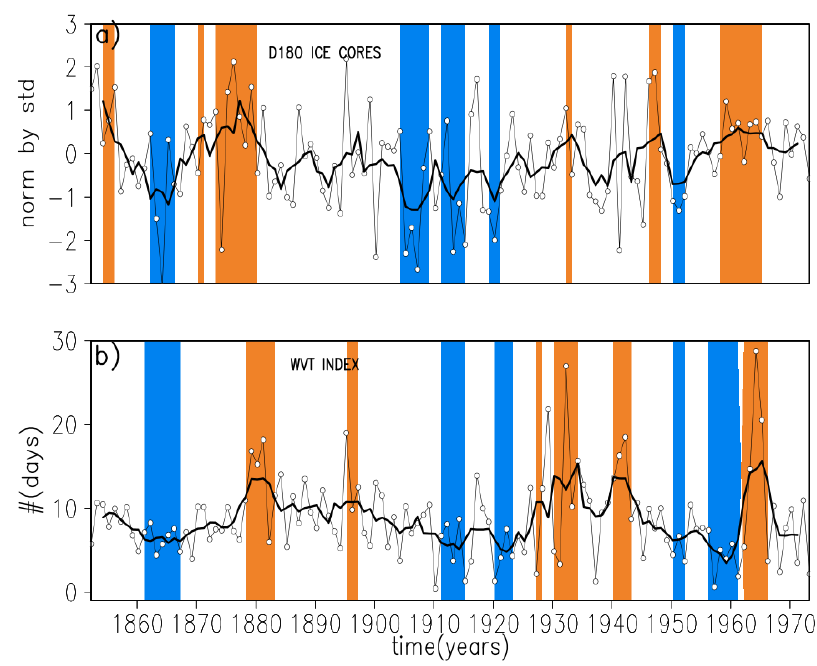
Figure 4. ( a ) Greenland ice core δ 18 O time series and ( b ) time series of the western Greenland extreme meridional WVT index (see text for definition) for 1851/52 to 1972/73 winters. Time intervals when the values in the smoothed time series (thick lines) are higher (lower) than 0.75 ( − 0.75) corresponding standard deviations are highlighted in orange (blue).